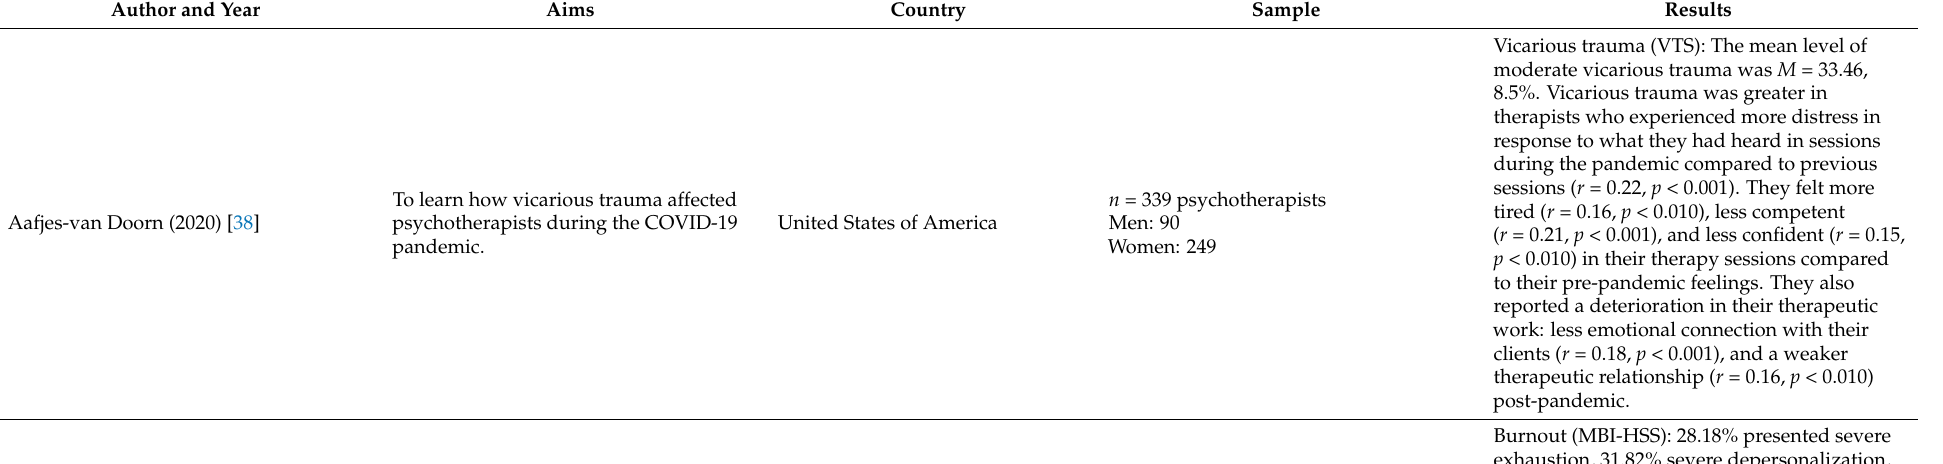
Table 1. The main characteristics of the studies included in this systematic